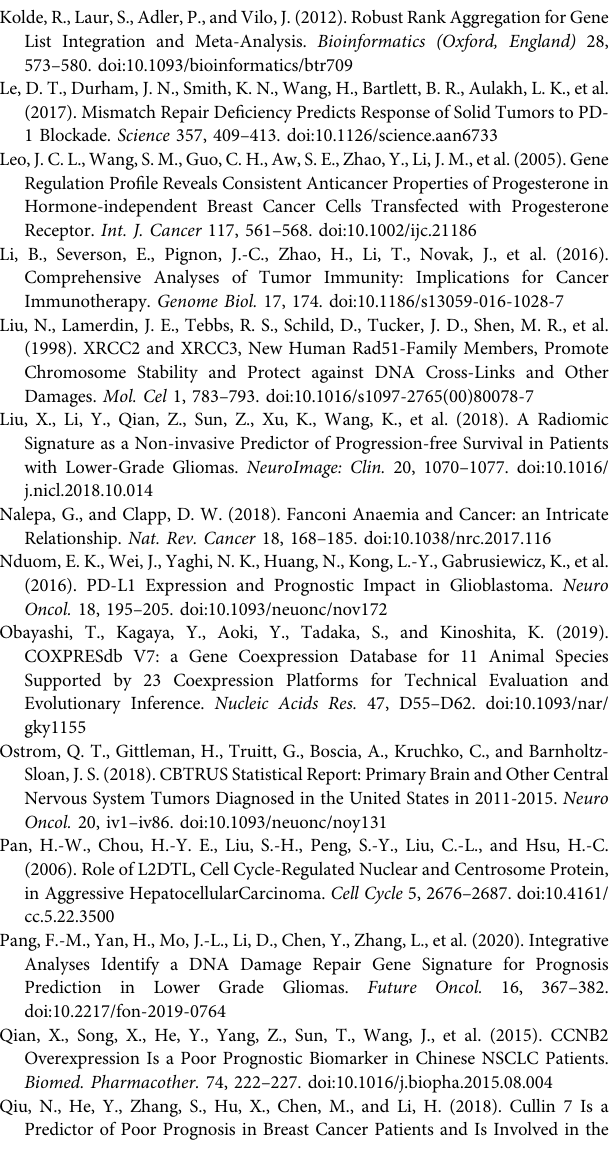
Supplementary Figure S1 |C1ORF112expression and prognostic value between cancer and normal tissues in GBM patients. (A) C1ORF112 mRNA is highly expressed in GBM tissues in TCGA dataset. (B) Survival curves of OS from TCGA dataset ( n (cid:1)